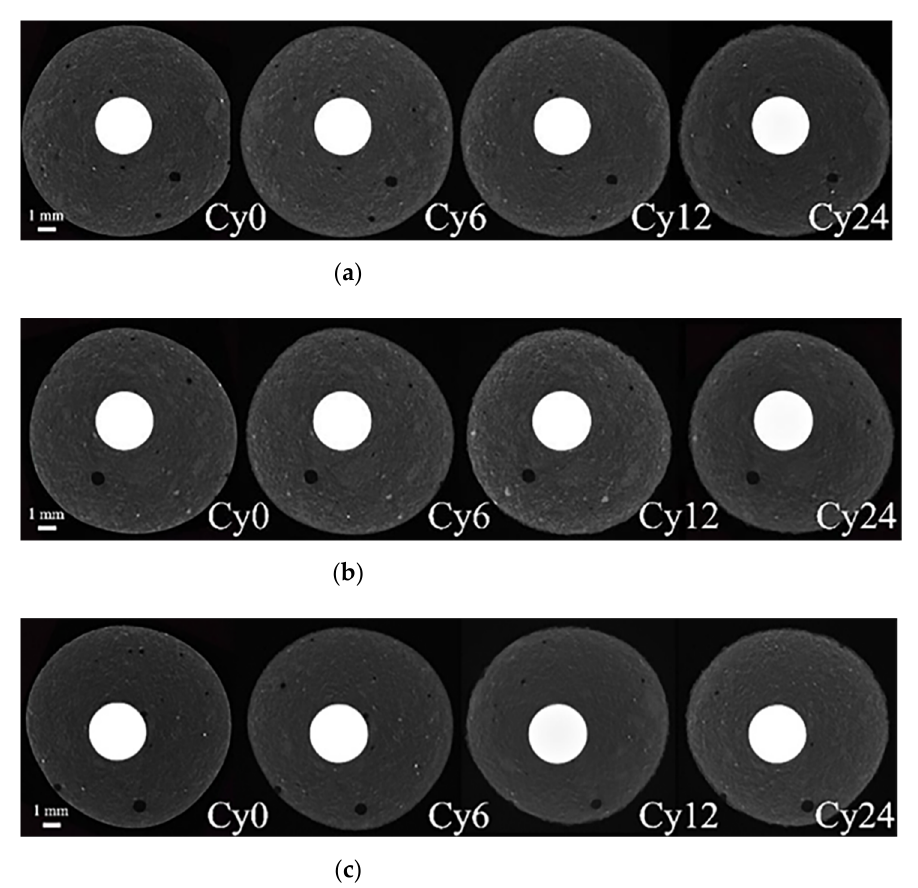
Figure 4. 2D slices from XCT results of specimens after different drying–immersion cycles: ( a ) Sc; ( b ) Ss, and ( c ) Scs.